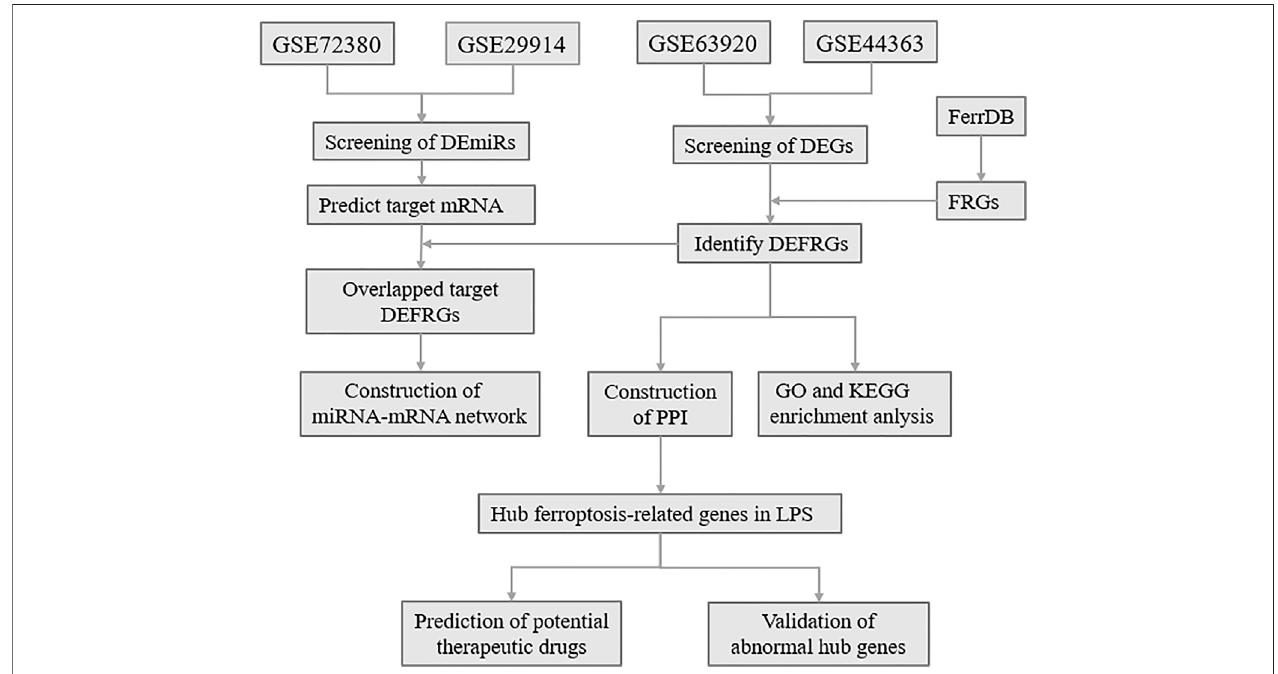
FIGURE 1 | The overall protocol of this study. DEmiRs, differentially expressed microRNA; DEmRs, differentially expressed mRNA; FRGs, ferroptosis-related genes; DEFRGs, differentially expressed FRGs; PPI, protein-protein interaction.